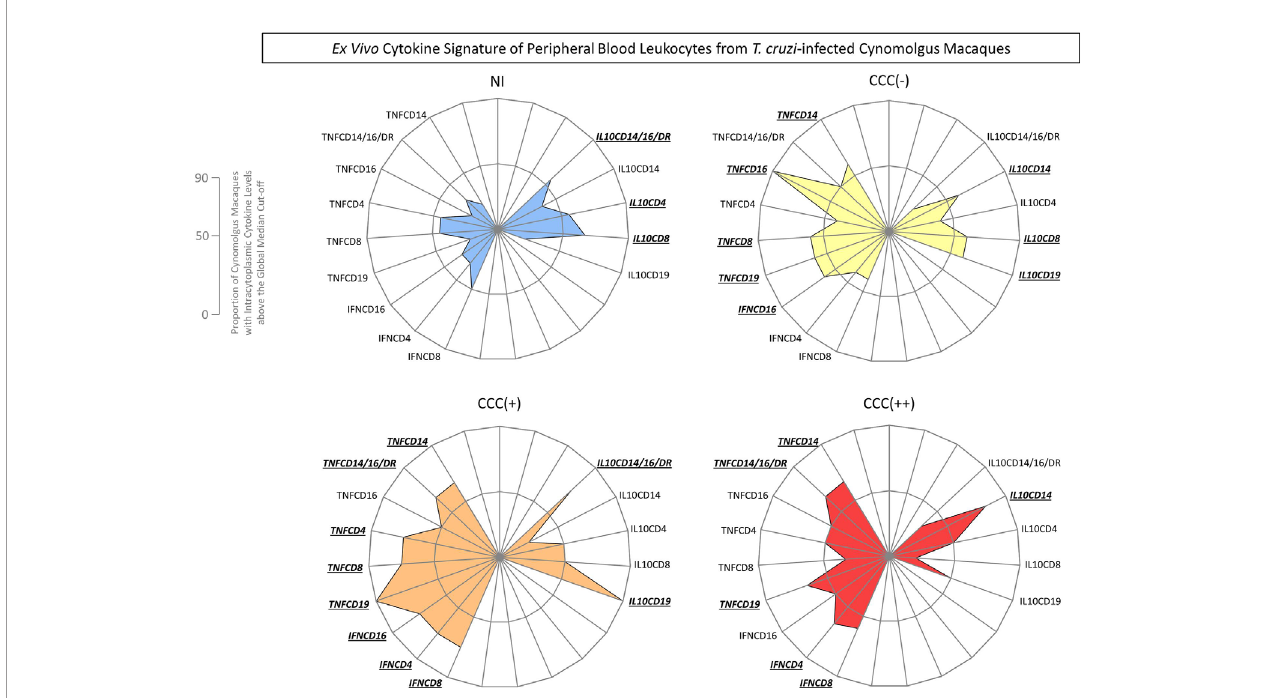
FIGURE 3 | Ex vivo cytokine signatures of peripheral blood leukocytes from T. cruzi -infected cynomolgus macaques classi fi ed according to histopathological features of chronic chagasic cardiopathy. The functional cytokine signatures were constructed based on the proportion of subjects with intracytoplasmic cytokine levels above the global median cut-off de fi ned for each cell subset, calculated for the entire study population. Radar charts were built to obtain the overall pro fi le of pro-in fl ammatory (left side) and regulatory (right side) cytokines for innate and adaptive immunity cells. Distinct color backgrounds were used to tag the non-infected controls (NI = ) and the subgroups of T. cruzi -infected cynomolgus macaques, classi fi ed according to histopathological features of cardiac biopsies and referred to as CCC( – ) for absence of chronic chagasic cardiopathy ( ); CCC (+) for mild chronic chagasic cardiopathy ( ) and CCC (++) for moderate chronic chagasic cardiopathy ( ). The biomarkers with frequencies above the 50 th percentile were highlighted for each group by bold underline